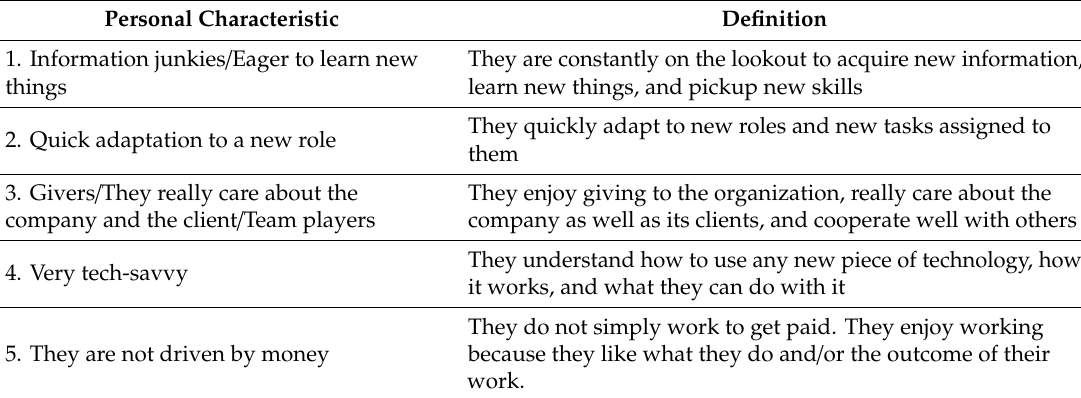
Table 5. Definitions of personal characteristics that the employees of an innovative technology enterprise may